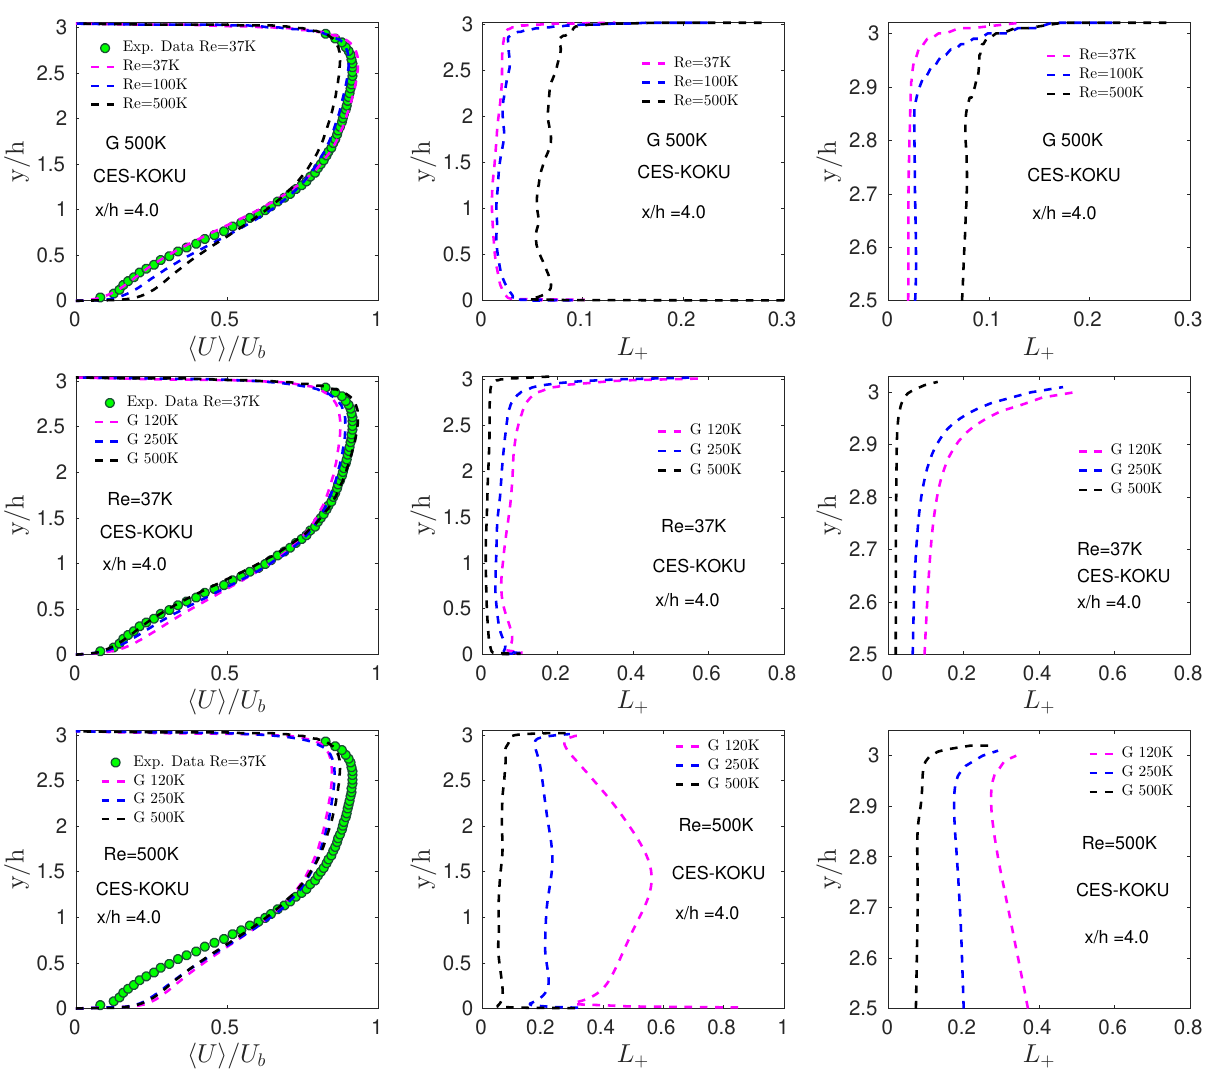
Figure 7. Profiles of (cid:104) U (cid:105) / U b , overall and upper wall L + obtained by CES-KOKU simulations at x / h = 4. Re and grids applied are specified in the plots. First row: Re effects using the 500 K grid. Second and third row: grid effects for Re = ( 37,500 ) K. Reprinted with permission from Ref. [17]. Copyright 2020 AIP